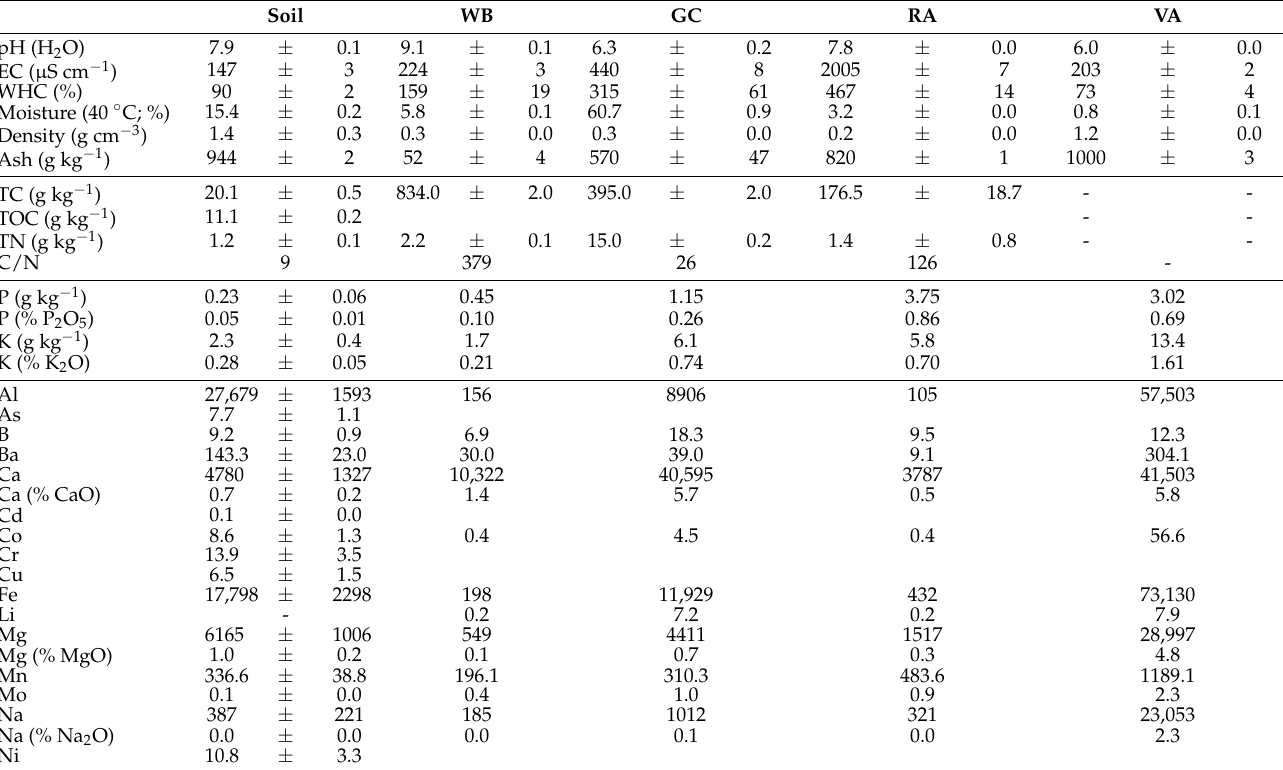
Table 1. Physical properties and elemental composition of bulk soil and